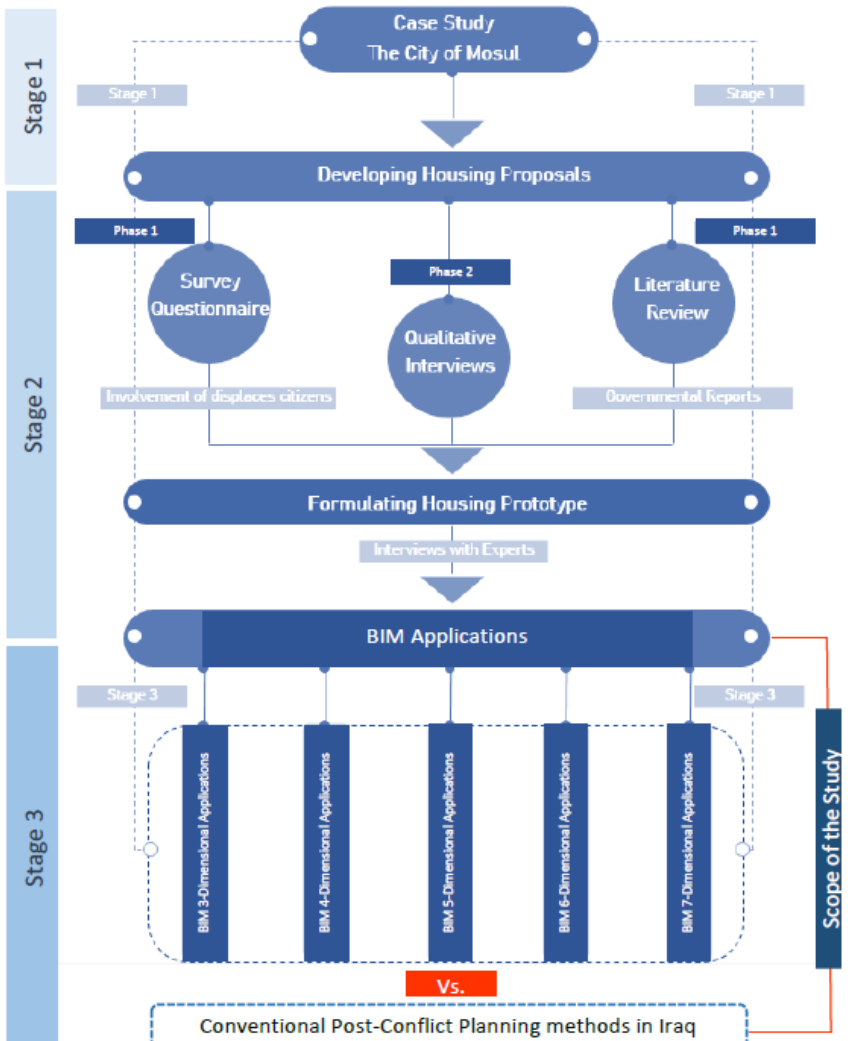
Figure 1. Research methodology framework and scope of study.